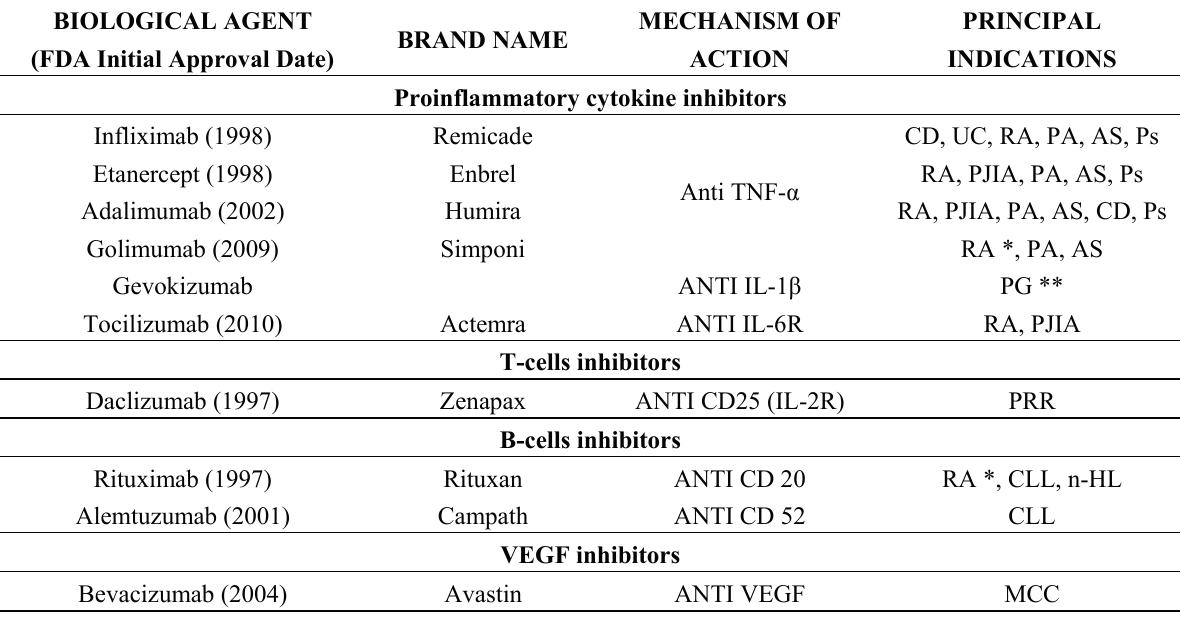
Table 1. Biological therapies to treat chronic systemic immunological-based diseases related to